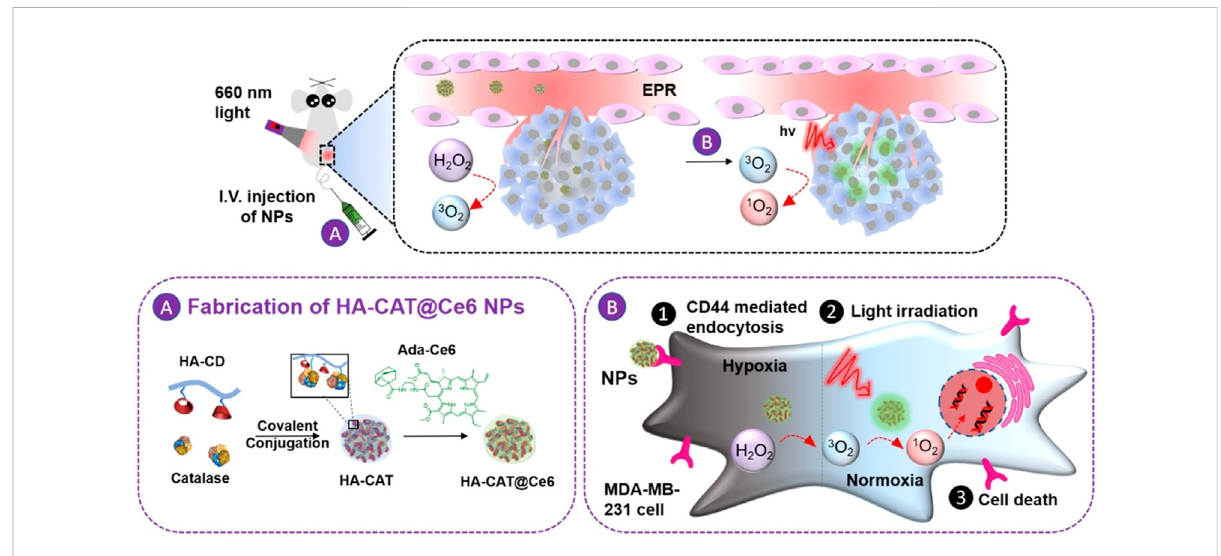
FIGURE 11 Schematic illustration of the preparation of HA-CAT@aCe6 NPs and the processes after intravenous injection into tumor-bearing mice. Reproduced with permission from Ref. (Phua et al., 2019).